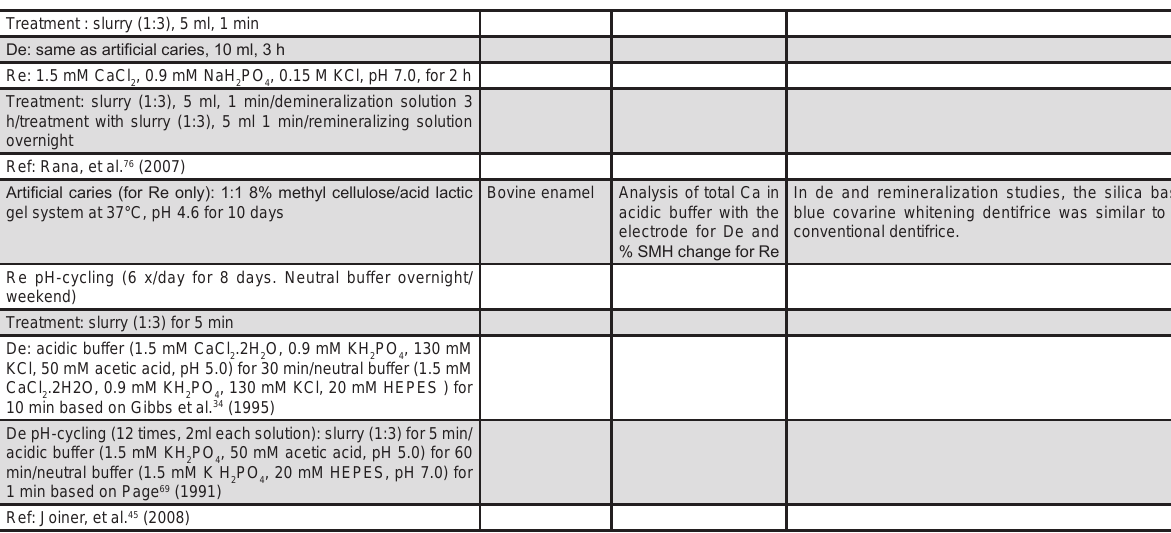
CONCLUSION VARIABLE could enhance that shown by Ketac-Fil and Fuji II LC, and could mask that shown by F2000.